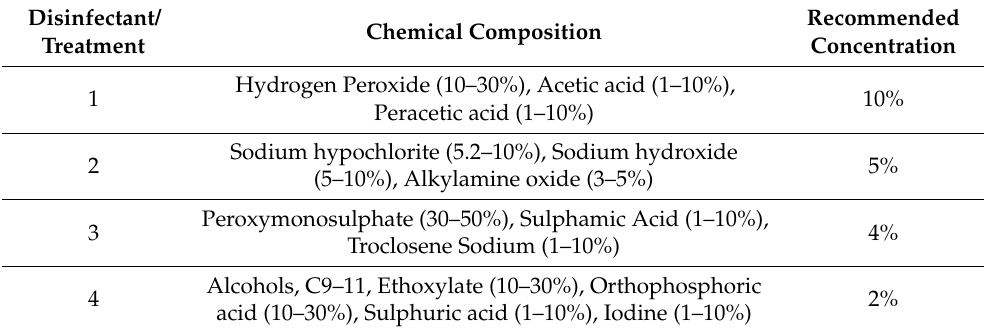
Table 1. The sporicidal product formulations and concentrations used in this study.